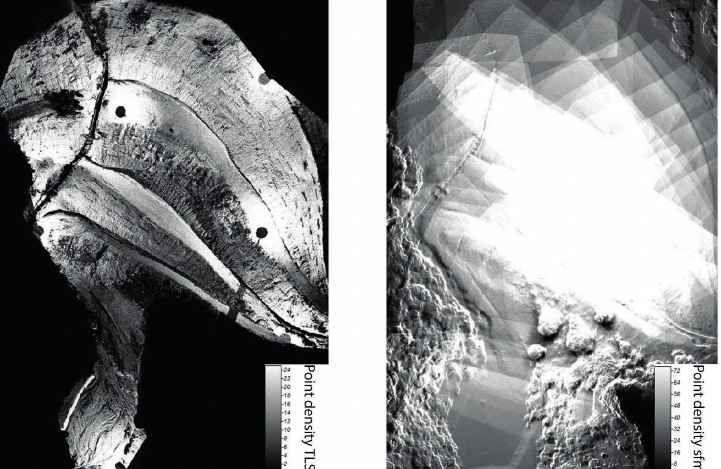
Fig. 5 Point densities for the Rio Marina study site. Note different colour scales for TLS (left) and sfm (right). Values indicate point count for each grid cell (20 × 20